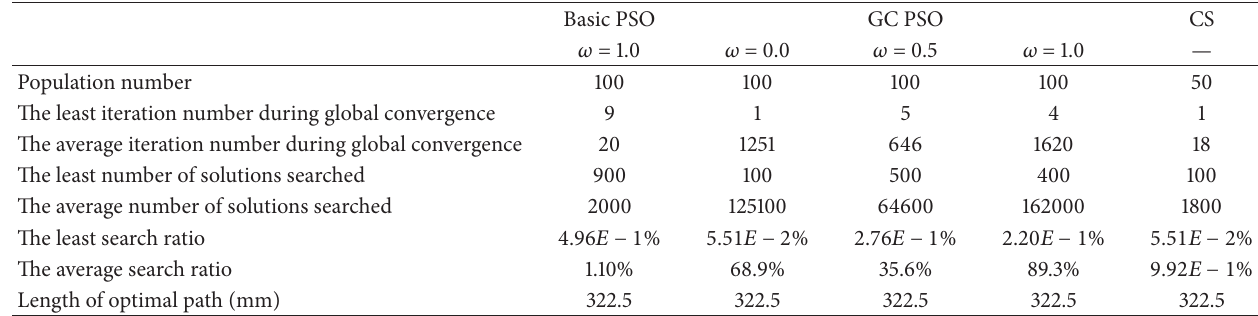
Table 5: Performance comparison of CS with variants of PSO on workpiece 1.